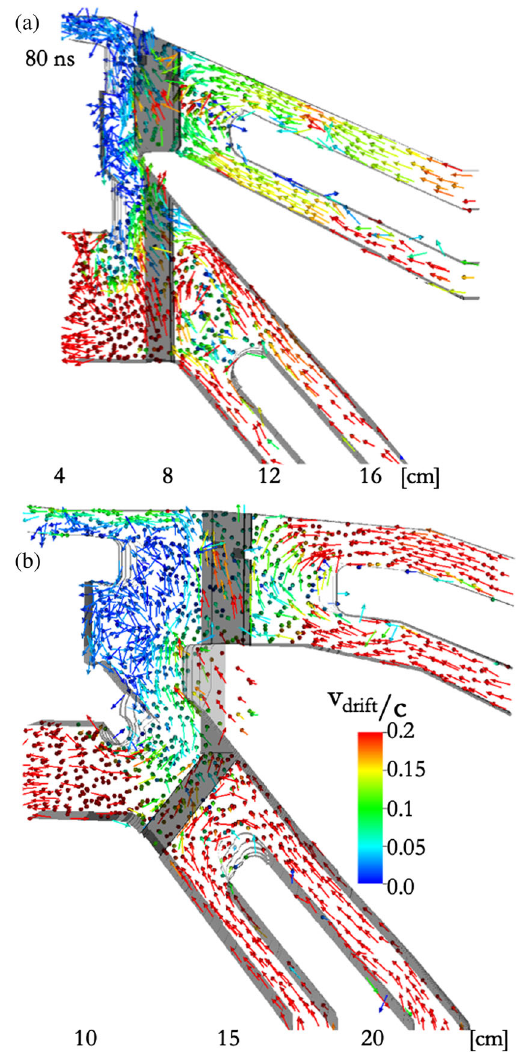
¼ E × B =B 2 in (a) the ∅ 15 cm and (b) the FIG. 7. v drift ∅ 31 cm convolutes at 80 ns.